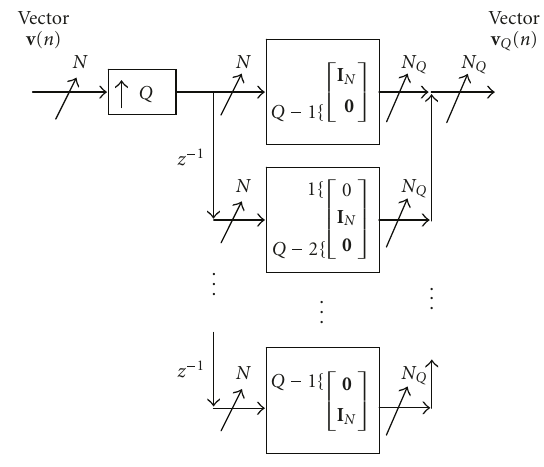
Figure 3: Q -repetition and shifting